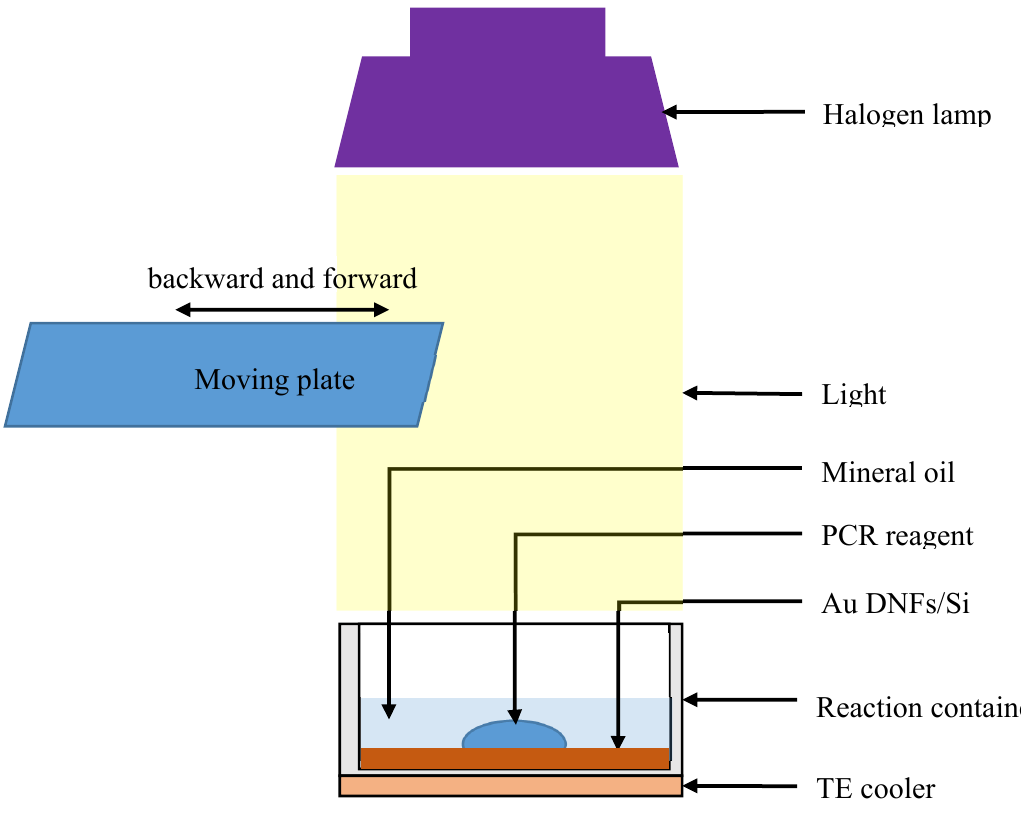
Figure 1. Schematic illustration of the PCR system containing the Au DNFs / Si chip, reaction container, TE cooler, moving plate, and halogen lamp.